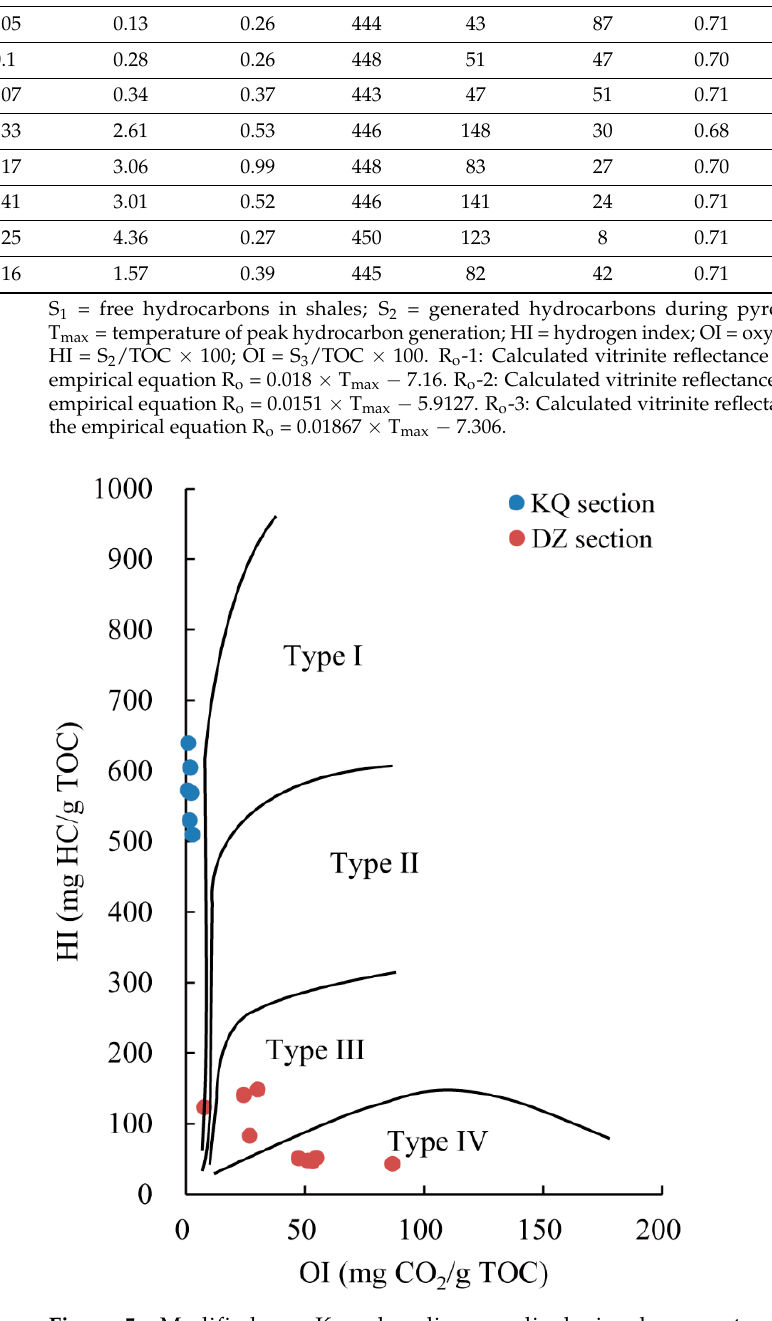
Figure 5. Modified van Krevelen diagram displaying kerogen types of the studied Chang 7 Member shales. Table 2. Total organic carbon (TOC) content and Rock-Eval pyrolysis results of the studied Chang 7 Member shale samples.